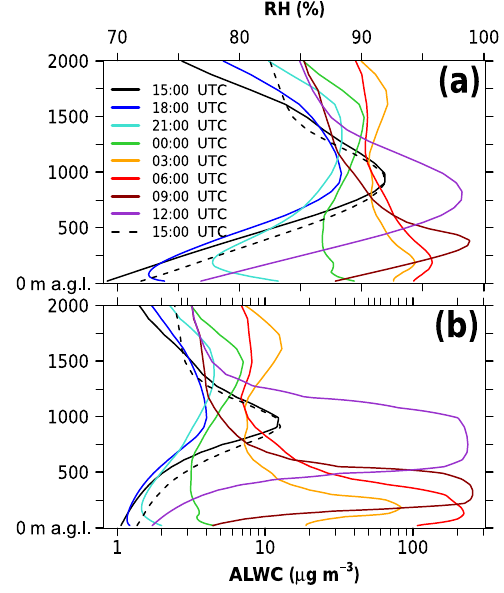
Figure 2. Vertical profiles (ma.g.l.) of (a) RH (%) and (b) ALWC (µgm − 3 ) for the median over the Ivory Coast (7.5–3 ◦ W, 4–10 ◦ N) between 2 July 15:00UTC (black solid) and 3 July 15:00UTC (black dashed). Consider the logarithmic abscissa of (b)